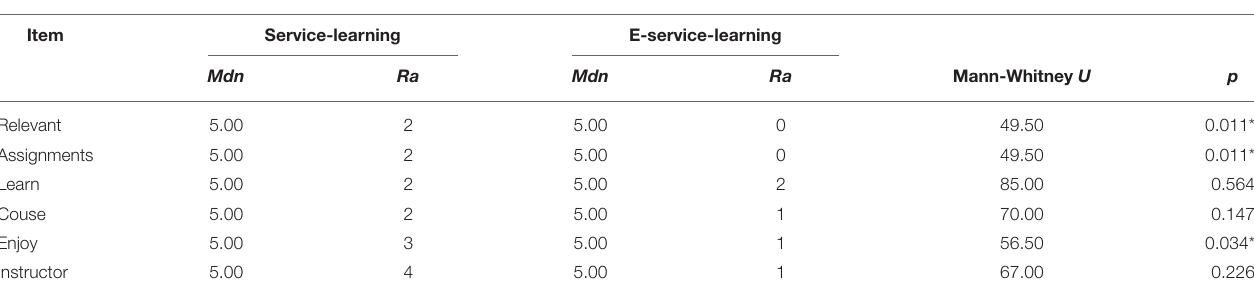
TABLE 2 | Course evaluation students’